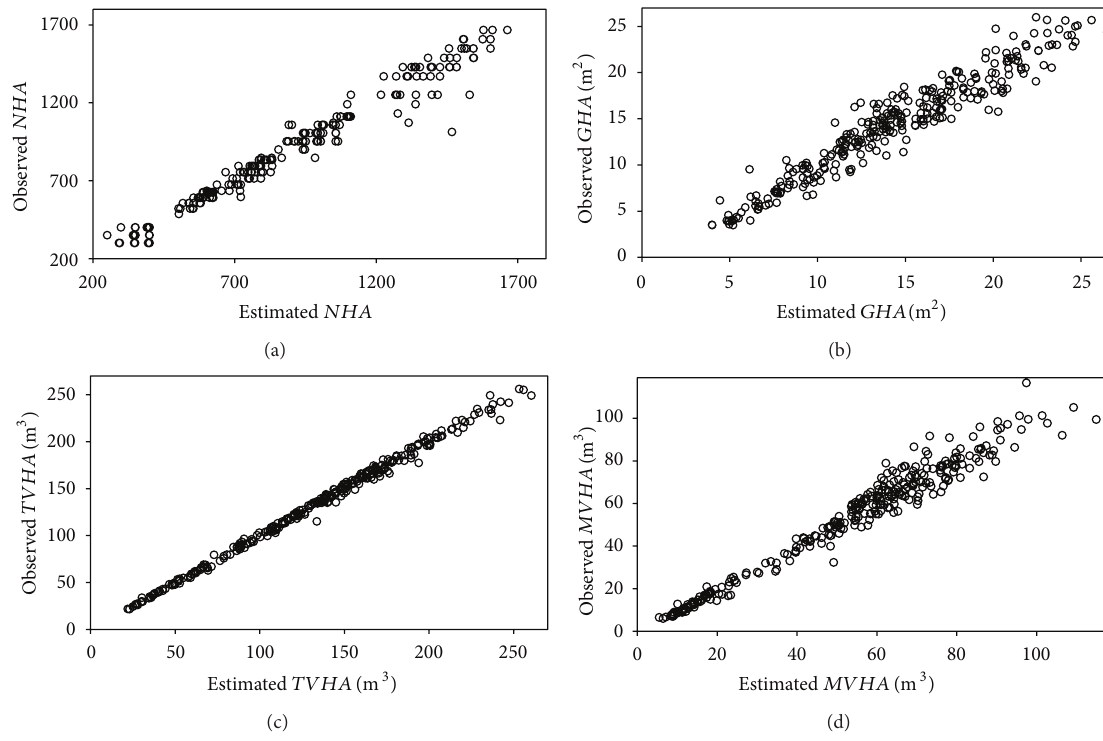
Figure 2: Graphical analysis of residues of Strategy B according to the models presented in Table